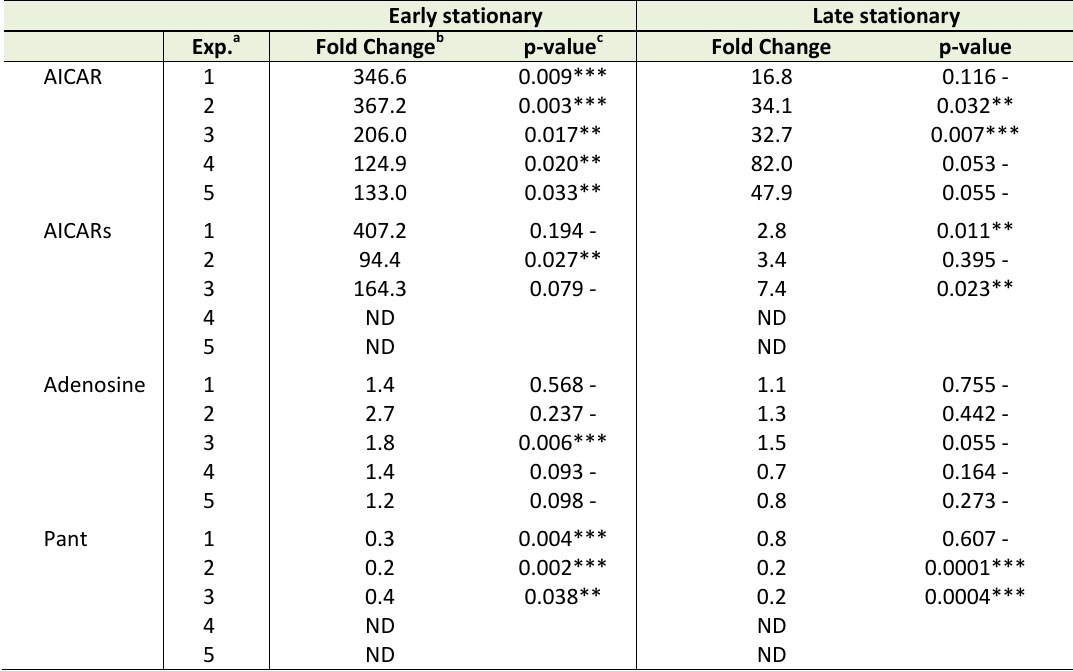
TABLE 2. Metabolomics captures known metabolic changes of a purH